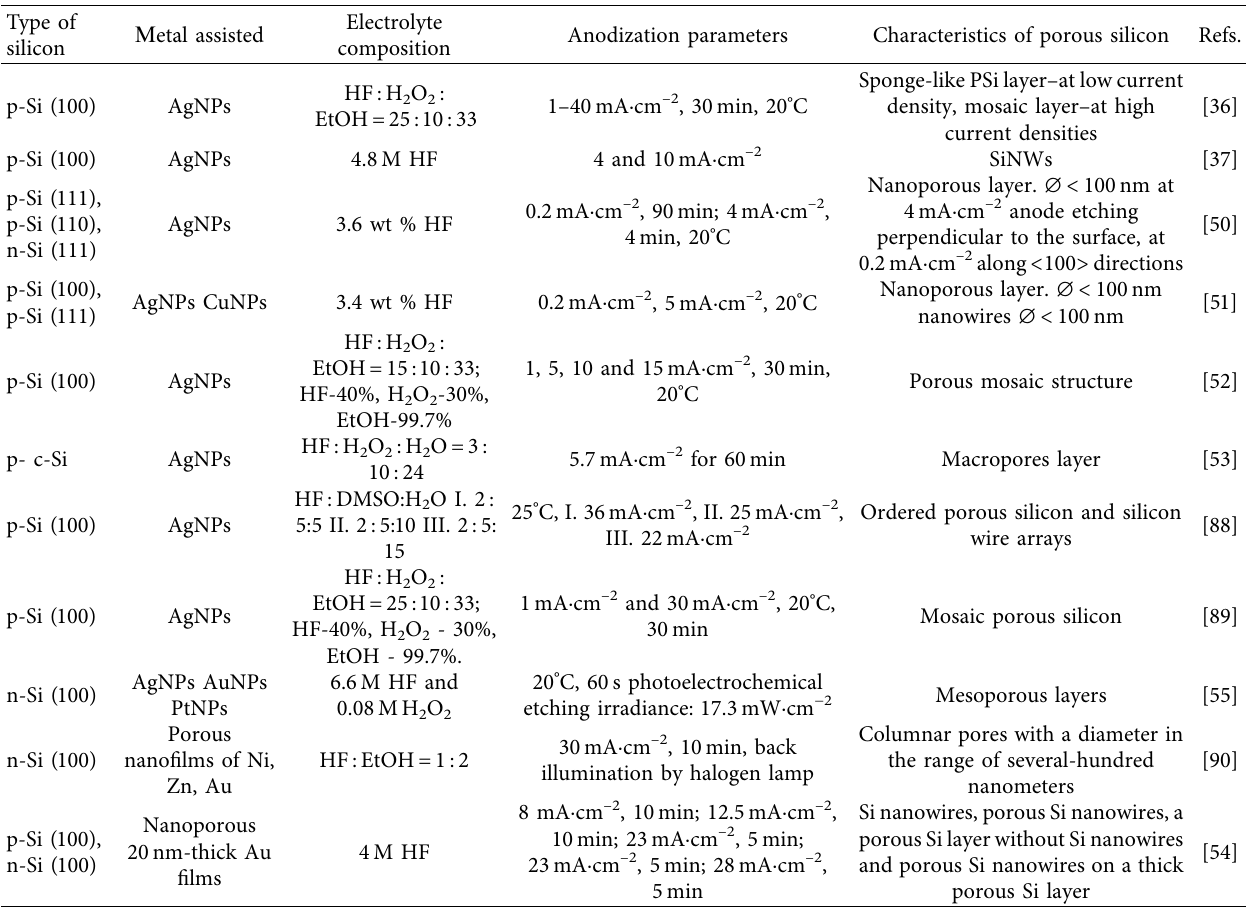
Table 3: Metal-assisted f lectrochemical anodic etching conditions for the formation of porous silicon.